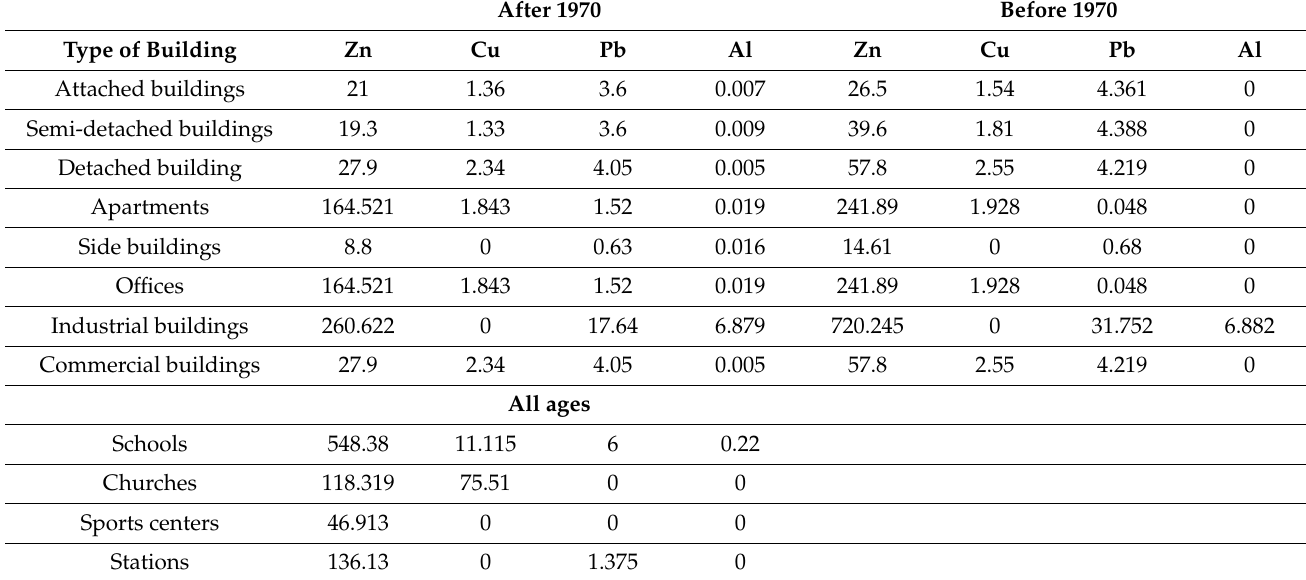
Table A2. Emission factors for buildings (g/building/year) in WEISS.